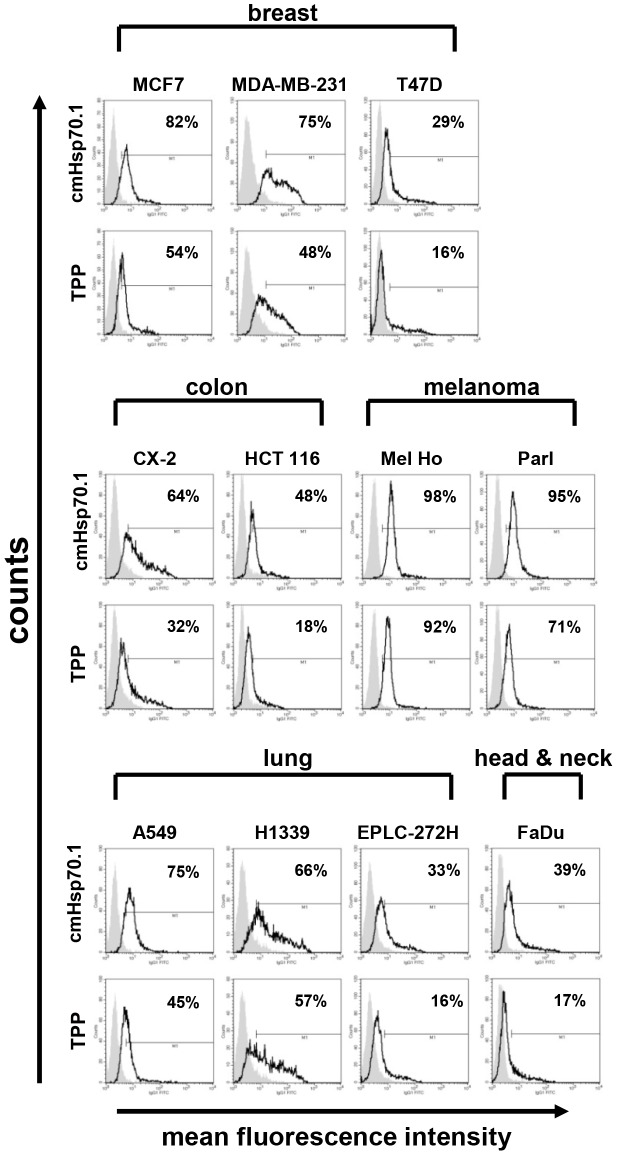
Tumor cell lines expressing memHsp70 are able to bind TPP at 4°C.The memHsp70 status of a panel of human breast, colon, melanoma, lung, head & neck tumor cell lines was assessed using the cmHsp70.1 antibody (top row histograms). Incubation of tumor cells with carboxyfluorescein (CF)-labeled TPP at 4°C (bottom row histograms) results in a similar binding profile to that of cmHsp70.1 antibody in all tumor cell lines; grey, isotype controls, open histograms, Hsp70 specific reagents. The numbers in the histograms show the proportion of Hsp70 membrane-positively stained cells.